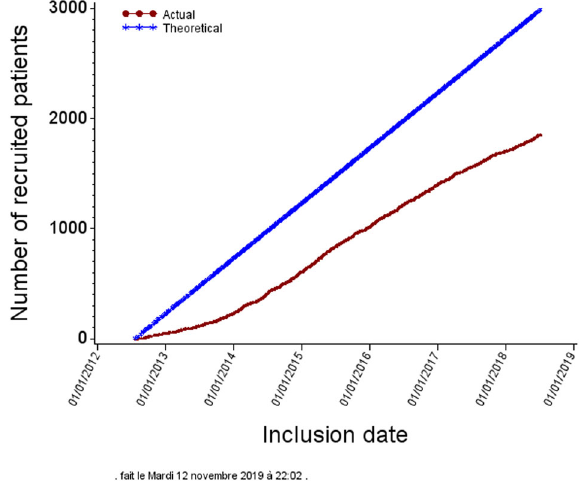
Fig. 1 Inclusion of patients. Inclusion number of patients in SERC trial (red line) in comparison with theoretical inclusion number planned